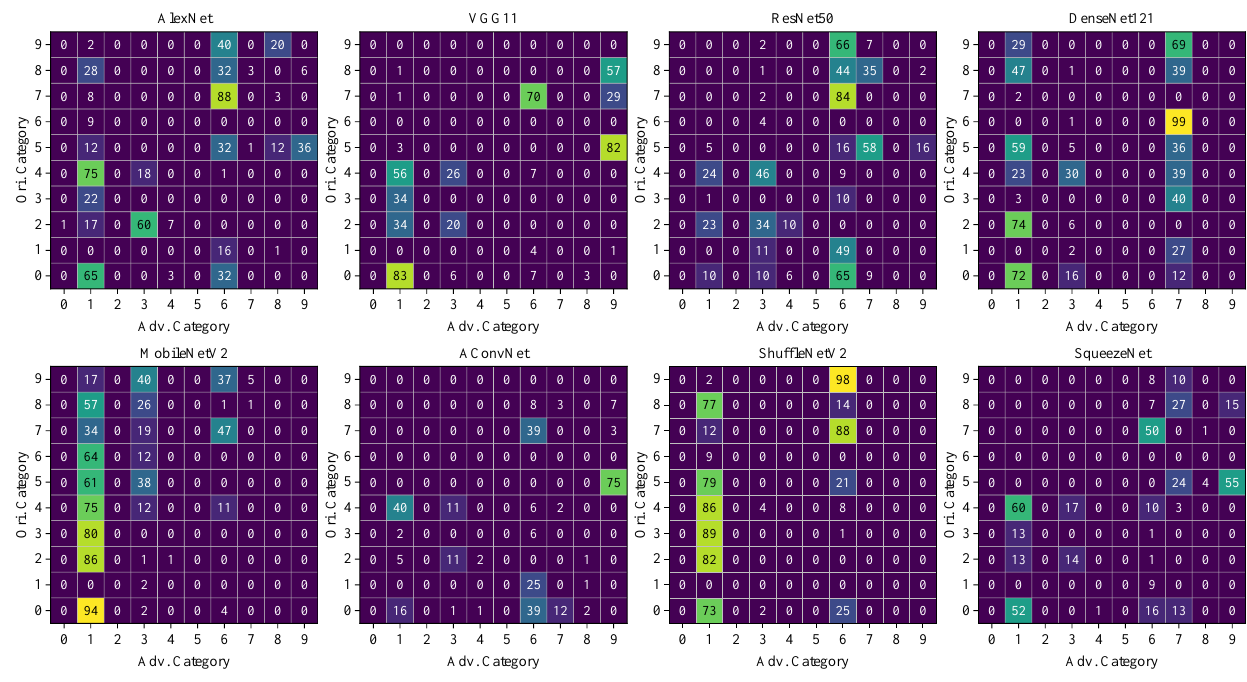
Figure A1. Distribution of adversarial labels. The attack is DF-UAP with MobileNetV2 as substitute model. Ori. Category refers to the ground truth category of targets, Adv. Category denotes the misclassified category of the universal adversarial examples. The number from 0 to 9 respectively indicates the following classes: 2S1, BMP2, BRDM2, BTR70, BTR60, D7, T72, T62, ZIL131, ZSU234.